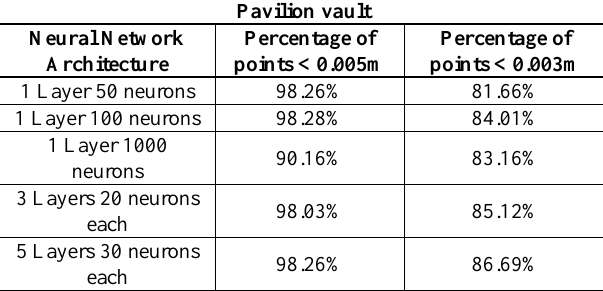
Table 3. “Pavilion Vault” data set results.